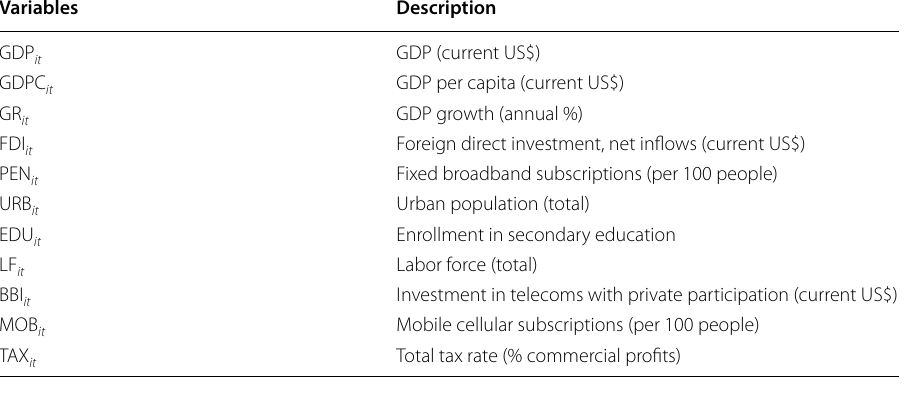
Table 1 List of variables used in the model and description Variables